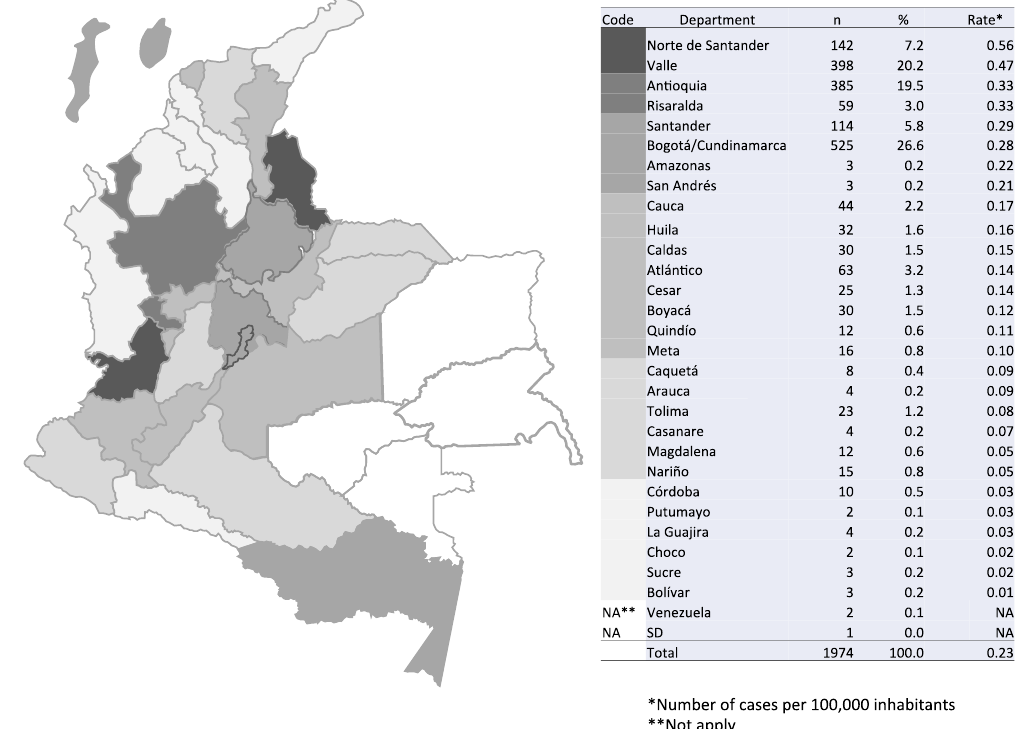
Figure 1. Distribution of cases of cryptococcosis in Colombia by rate and department of